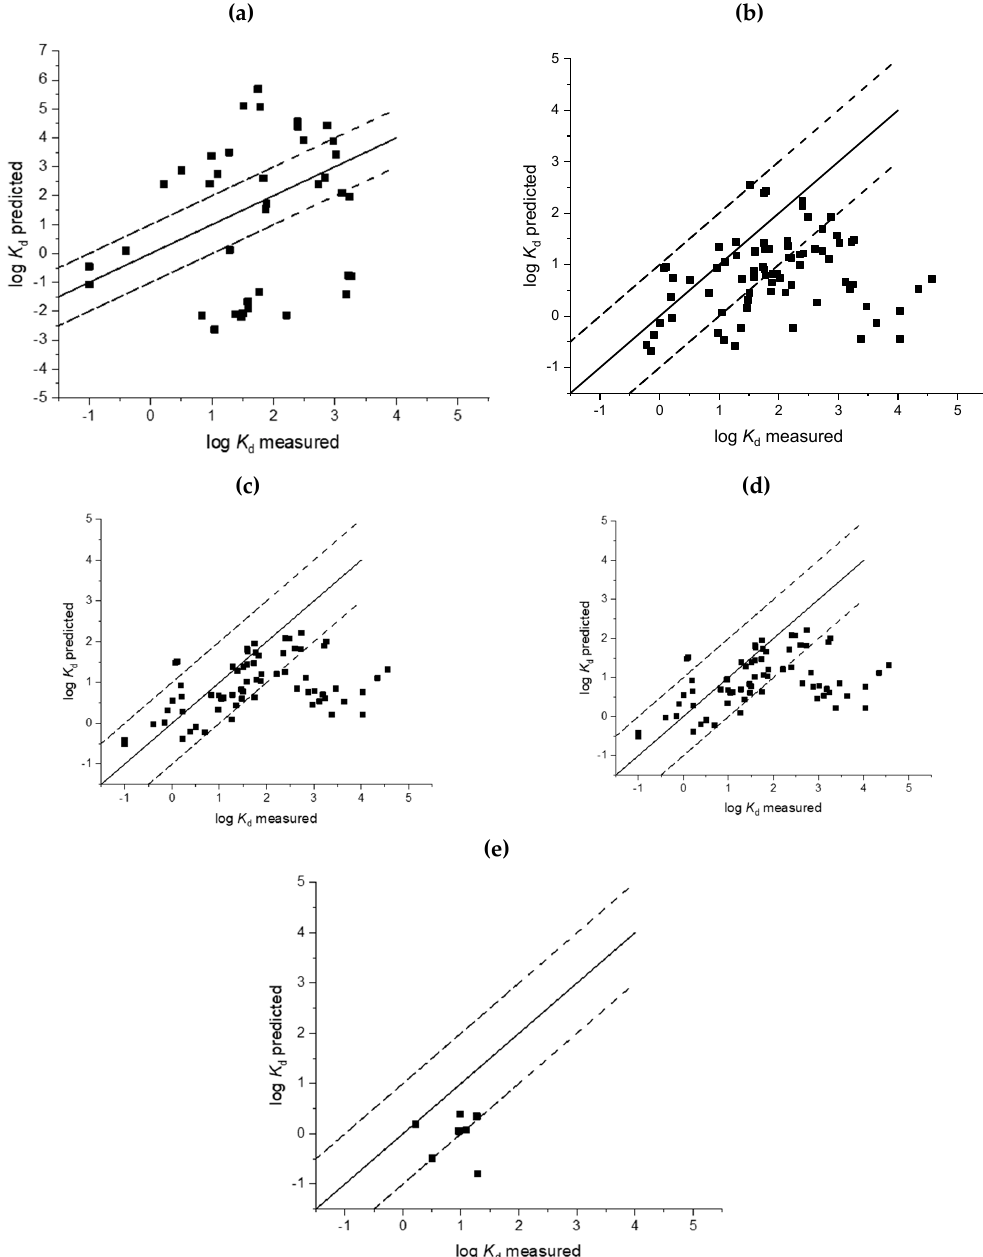
Figure 2. Comparison of predicted and measured soil sorption coefficients (log K d ) for acidic pharmaceuticals Bintein and Devillers [28] ( a ); Sabljic et al. [37] ( b ); Franco et al. [31] ( c ); Franco et al. [16] ( d ); Kah and Brown [24] ( e ).